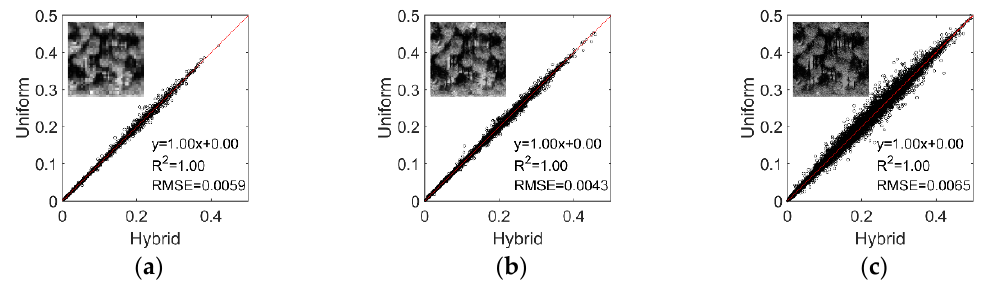
Figure 10. Accuracy comparison of the hybrid and uniform approaches when simulating remote sensing images of the RAMI forest scene at three spatial resolutions: ( a ) 0.5m, ( b ) 0.25m and ( c ) 0.1. Table 1. Computational resources used by simulating the BASEL scene with di ff erent approaches. Table 2. Computational resources used by simulating the RAMI forest scene. BASEL Time (s) Memory (GB) Null Voxel (%) Resolution Uniform Hybrid Speedup Uniform Hybrid Decrease